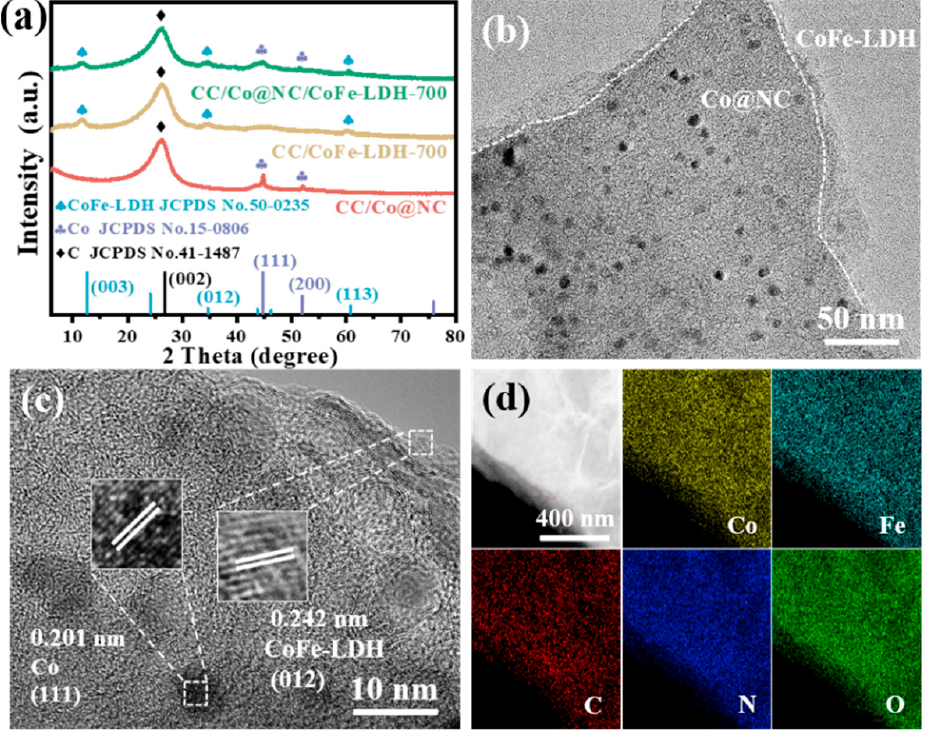
Figure 2. ( a ) XRD patterns of related samples. ( b ) TEM and ( c ) HRTEM images of CC/Co@NC/CoFe-LDH-700. ( d ) Elemental mapping images of CC/Co@NC/CoFe-LDH-700. The valance state and electron interaction of the constituting elements in CC/Co@NC/CoFe-LDH-700 were further investigated by XPS. It can be seen from the XPS full spectra